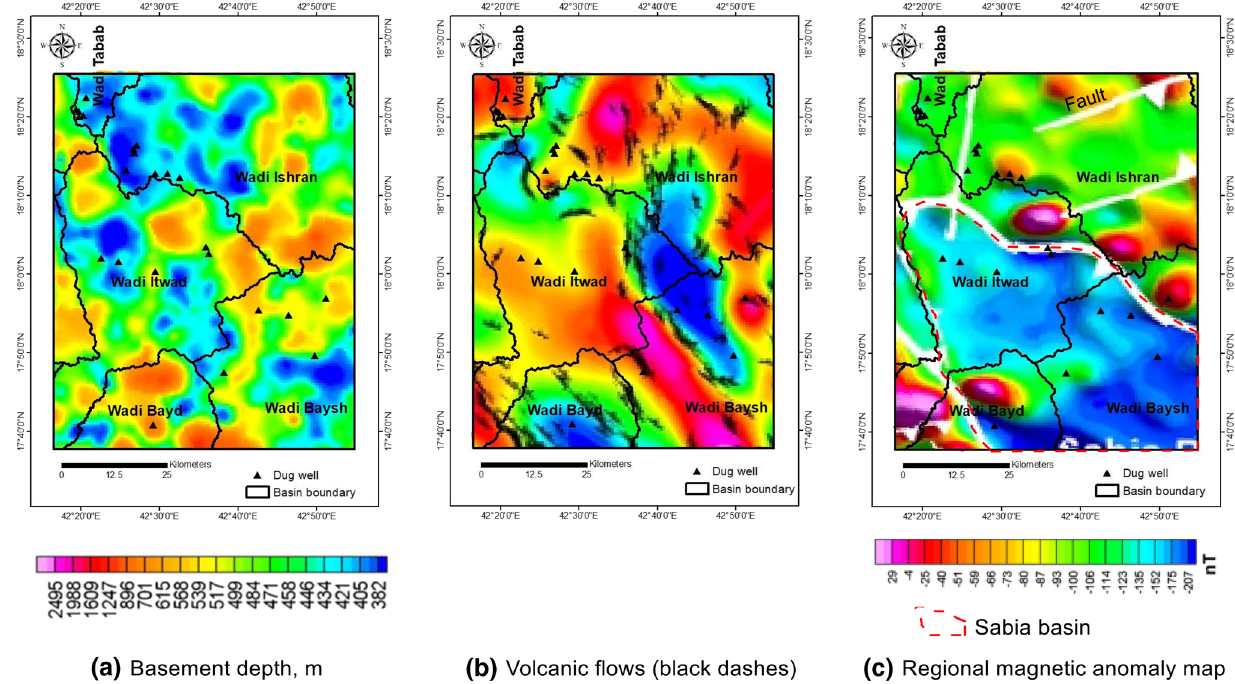
Fig. 15 a Magnetic sources, b source edge detection, and c regional anomaly magnetic map (after Elawadi et al.